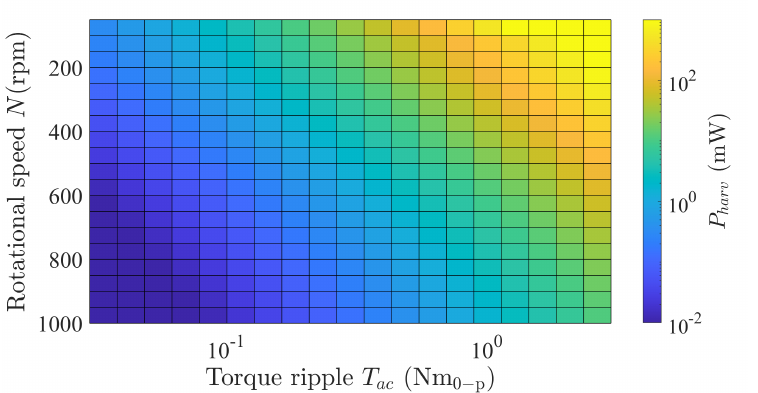
Figure 6. Simulated results of harvested power as a function of rotational speed and torque rip- ple amplitude.